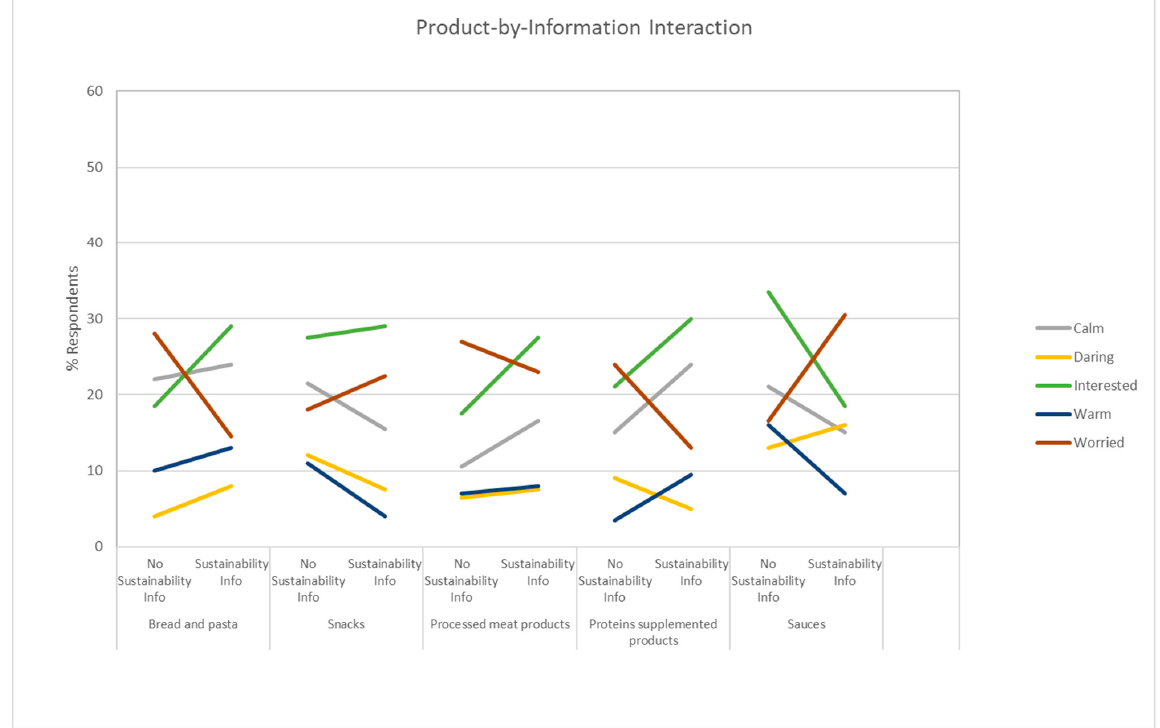
Figure 7. Effects of the interaction between the Sustainability information and the Product Category for the feelings calm, daring, interested, warm, and worried. The y-axis indicates the percentage of respondents checking the emotions, values that have been plotted using the regression model built from the ANOVA results, and the x-axis is the Insect Presence Information by each Product